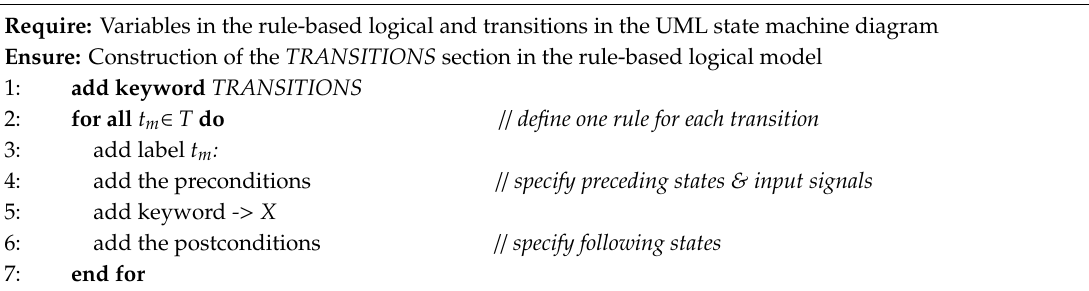
Algorithm 3. Generation of the TRANSITIONS section in the rule-based logical